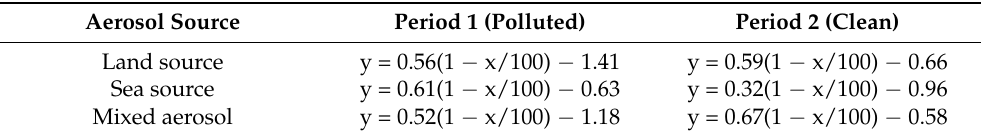
Table 5. Fitting parameters of HGF ext and evaluation indexes for different-sourced aerosols in each season.